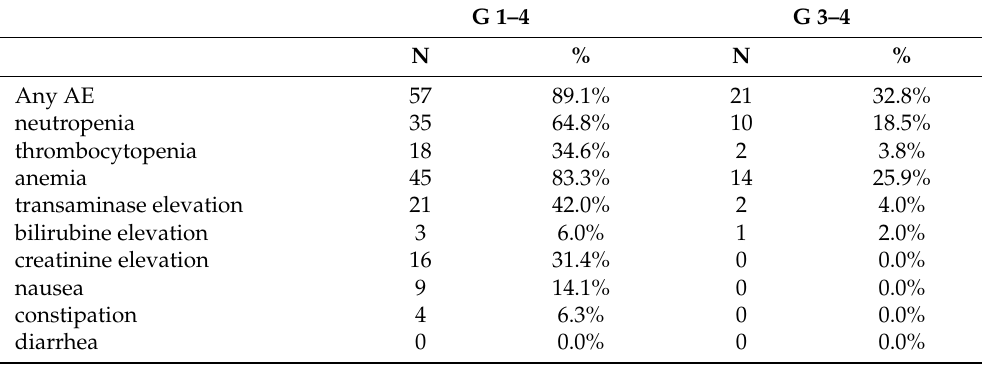
Table 2. Treatment-emergent adverse events in patients receiving metronomic